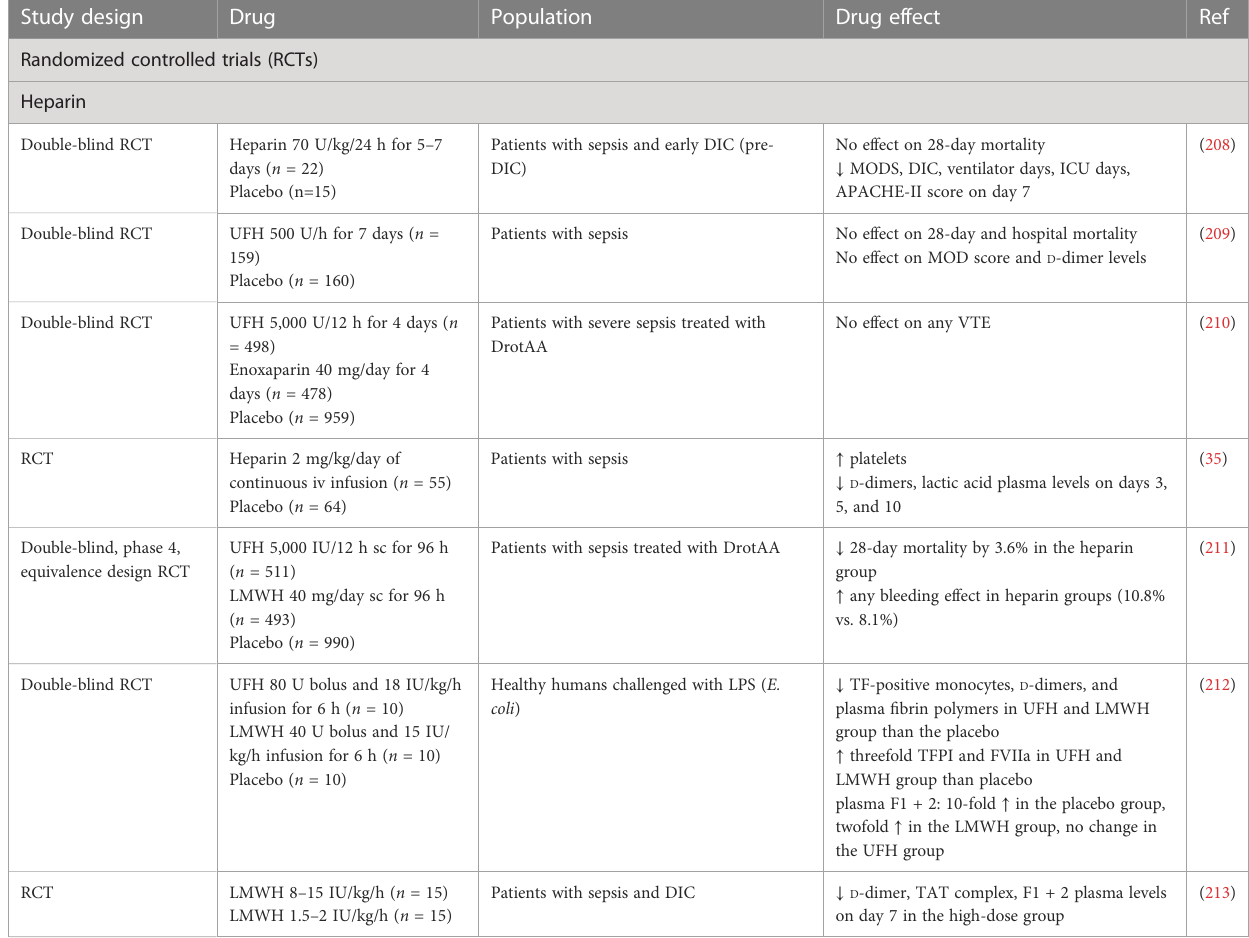
TABLE 6 Clinical studies assessing current anticoagulant and antithrombotic drugs in sepsis outcomes. Study